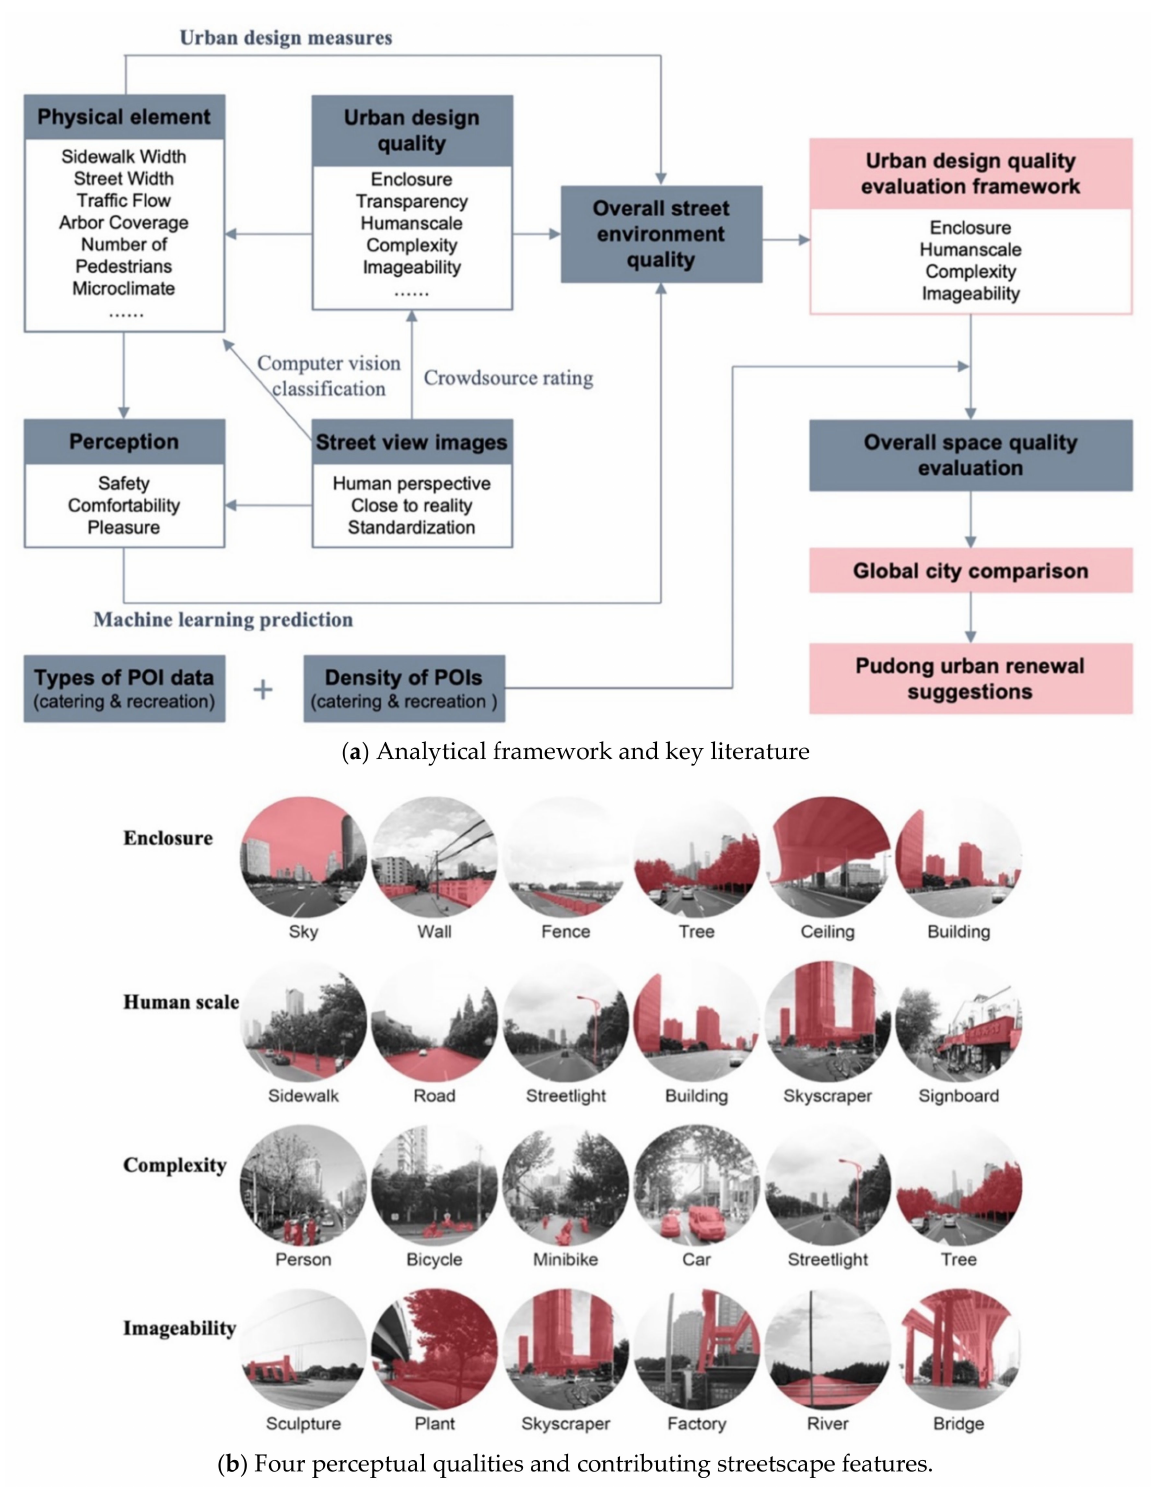
Figure 1. Analytical framework ( a ) based on literature in urban design qualities and ( b ) the selection of the four perceptual qualities and their contributing